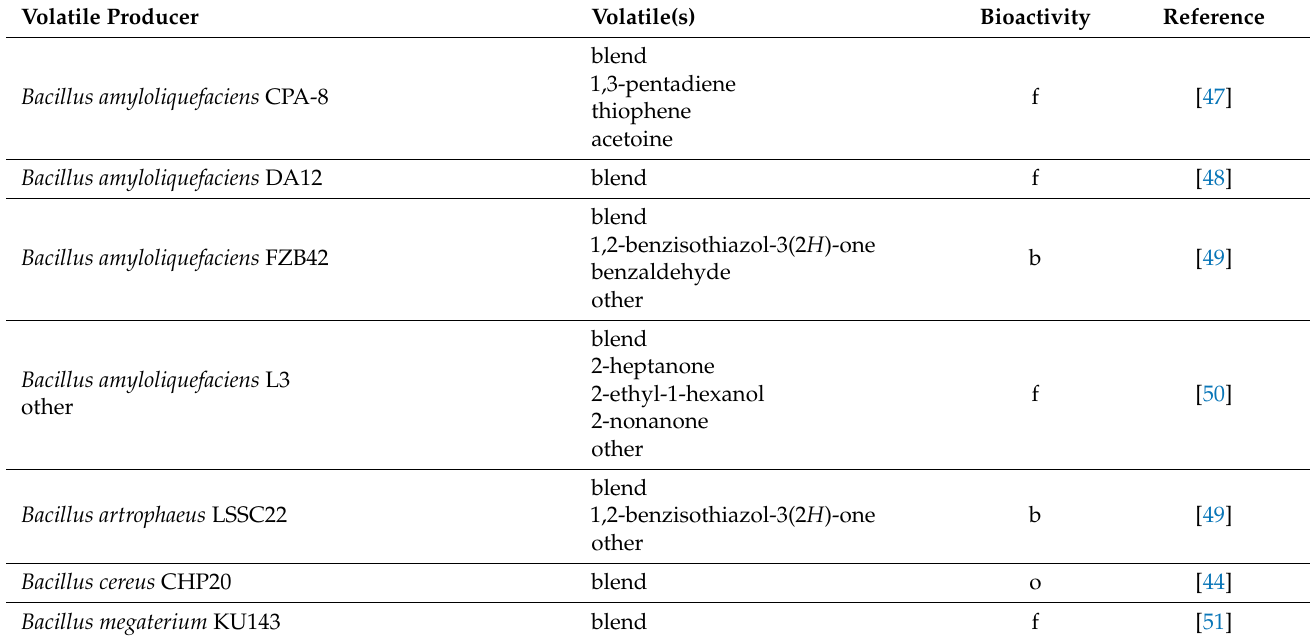
Table 1. Overview of recent (2017–2021) studies showing the antimicrobial activity of bacterial volatiles. The studies are ordered alphabetically by the volatile producer’s name. Only studies that trapped the antimicrobial volatiles in the gas phase and/or showed the antimicrobial effect via the gas phase are listed. blend = The volatile blend might be analyzed in the cited study but only the antimicrobial activity of the blend was tested. f = antifungal, b = antibacterial, o =